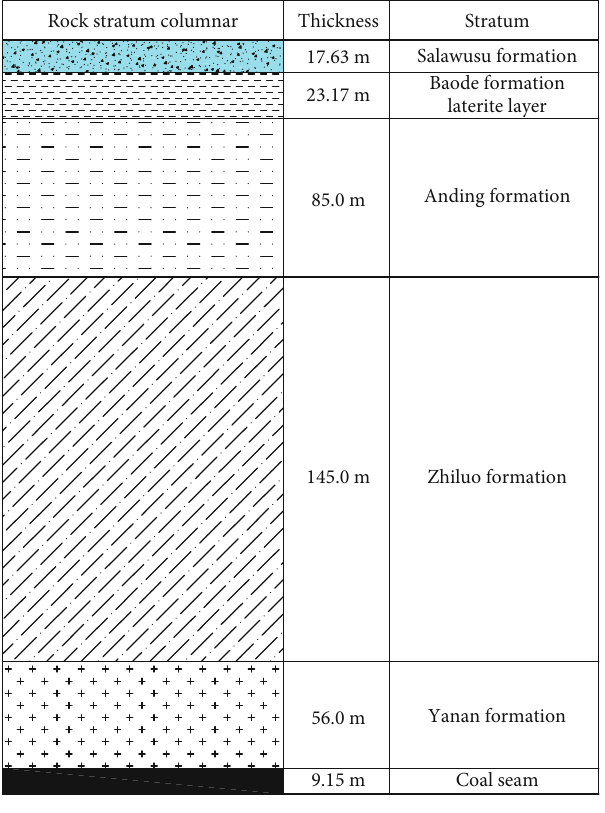
Figure 2: Comprehensive histogram of the testing area with water- protection mining.